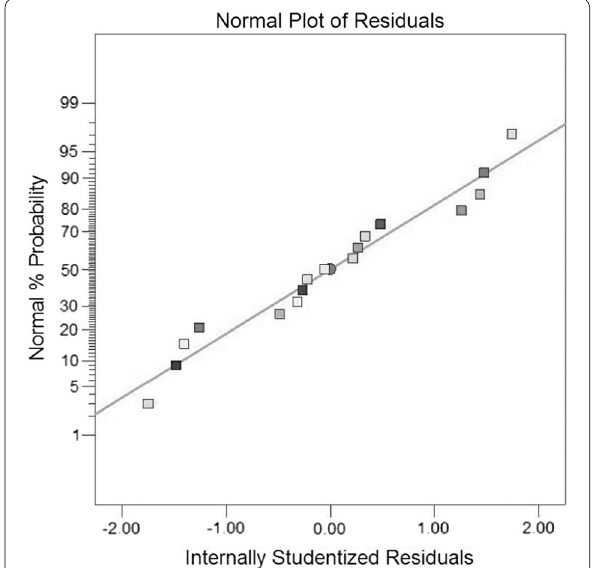
Fig. 1 Growth kinetics of Escherichia coli in the basal fermentation condition